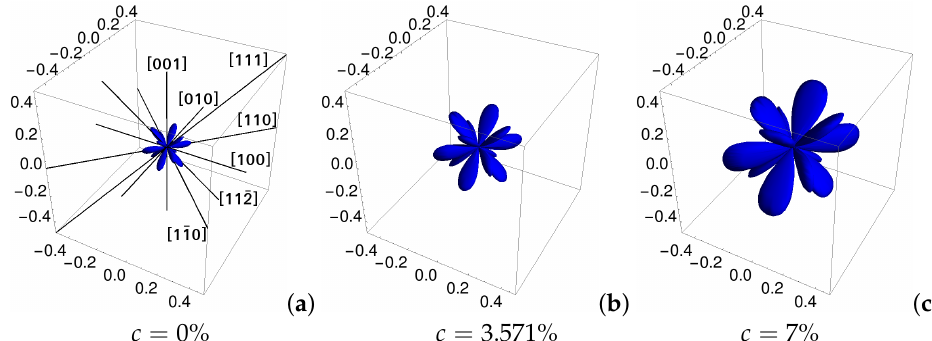
Figure 6. Absolute value of the minimal negative Poisson’s ratio in all crystallographic directions for Yukawa systems with nanochannels in the [ 111 ] -direction for inverse screening length κσ = 10 and various concentrations: ( a ) c = 0%; ( b ) c = 3.571%; and ( c ) c = 7%.